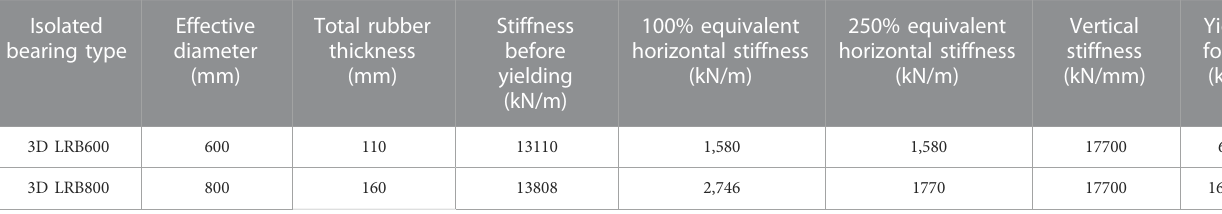
TABLE 8 Design parameters of 3D LRB isolated bearing.